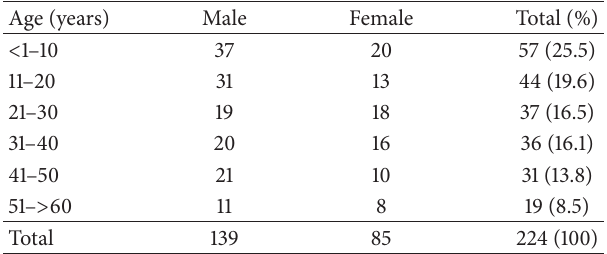
Table 1: Age and sex distribution.